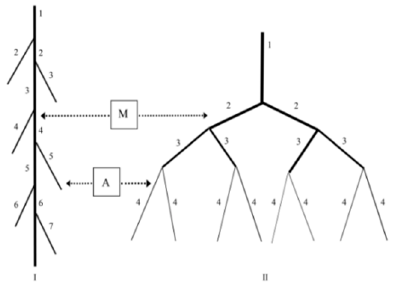
Figure 1. Schematic view of root system topologies. I, herringbone branching (A = 7, M = 7); II, dichotomous branching (A = 4, M = 8).